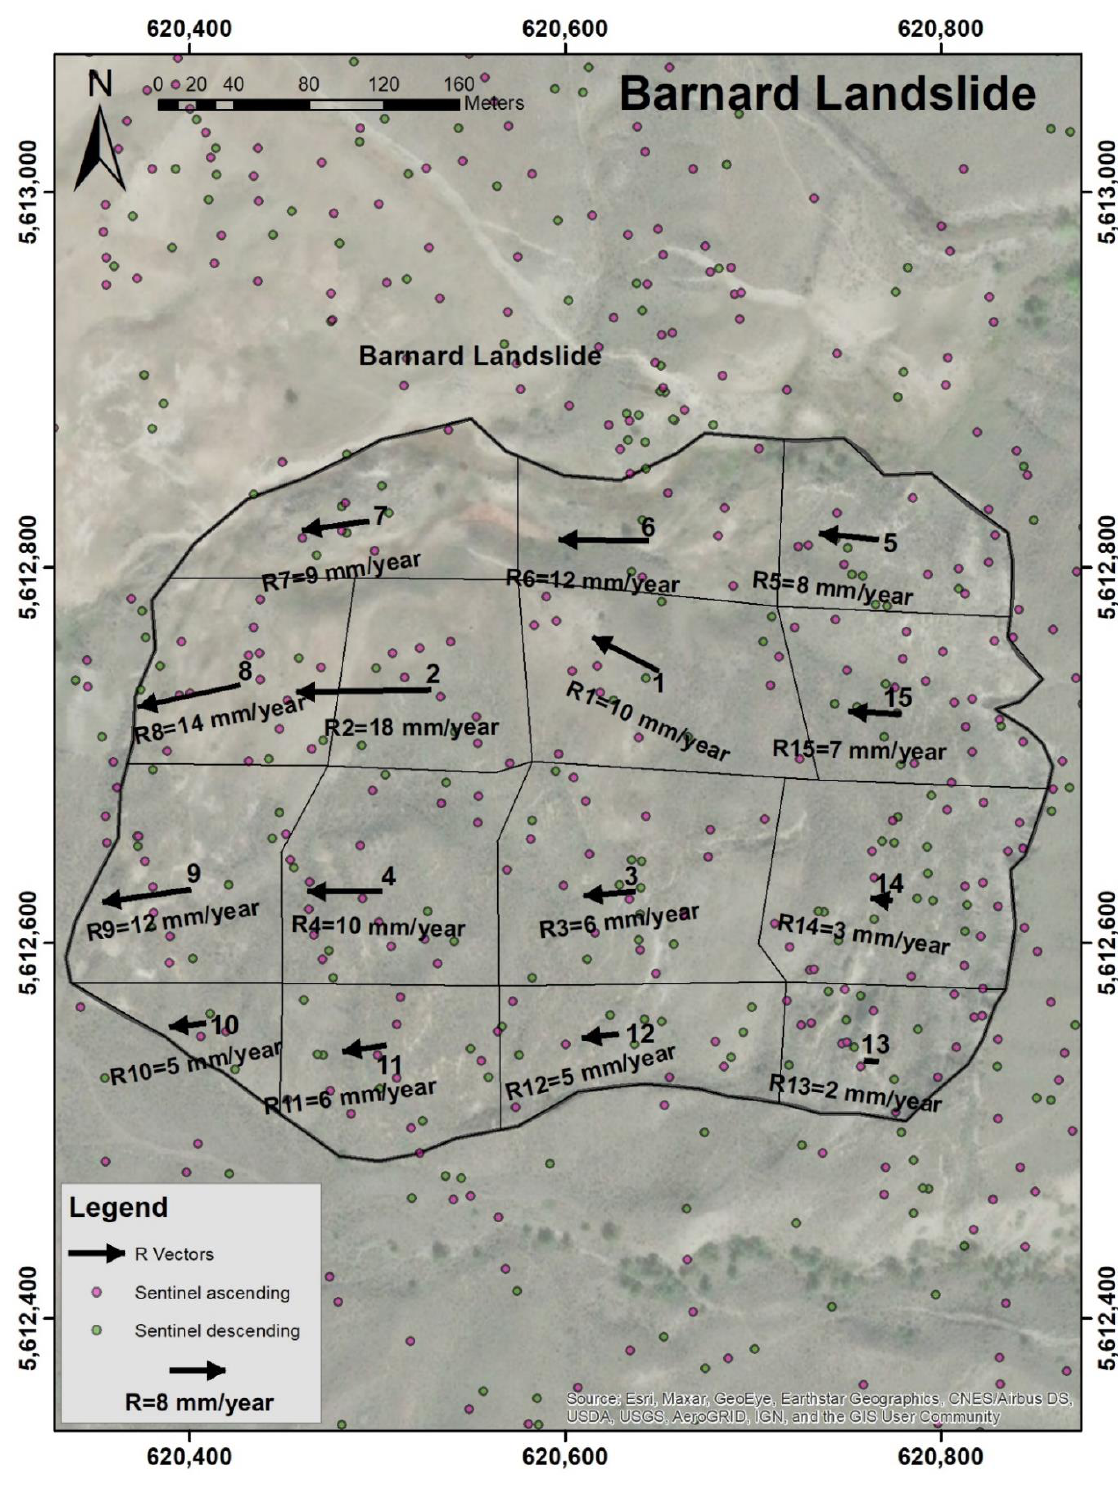
Figure 22. Calculated horizontal component of R within the Barnard landslide.